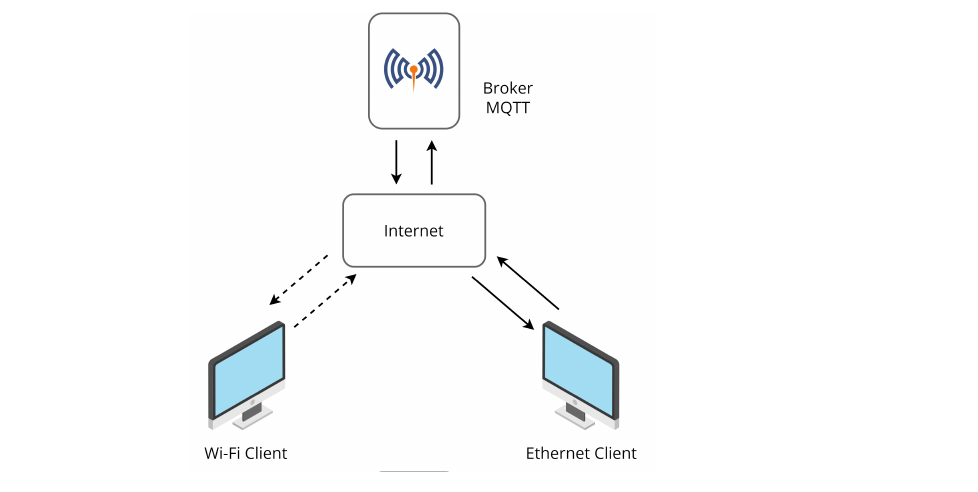
Figure 4. Infrastructure of the